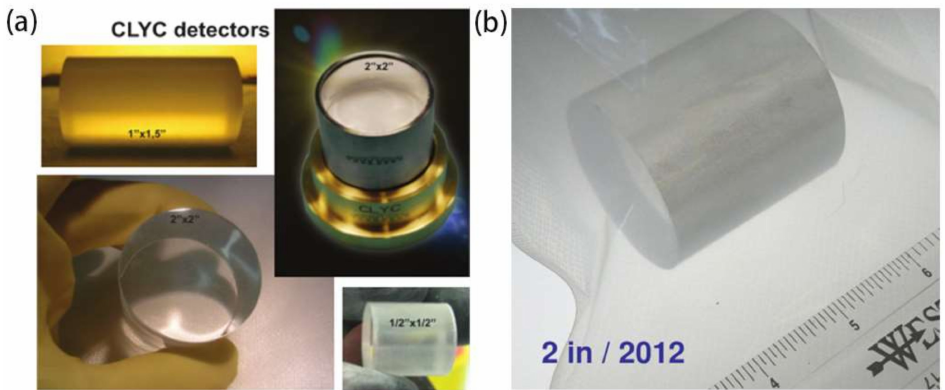
Figure 6. ( a ) CLYC crystals grown by RMD. Reproduced with permission [40]. Copyright 2013, Elsevier B.V. ( b ) CLYC crystals grown by the Saint-Gobain company. Reproduced with permission [34]. Copyright 2013, Saint-Gobain